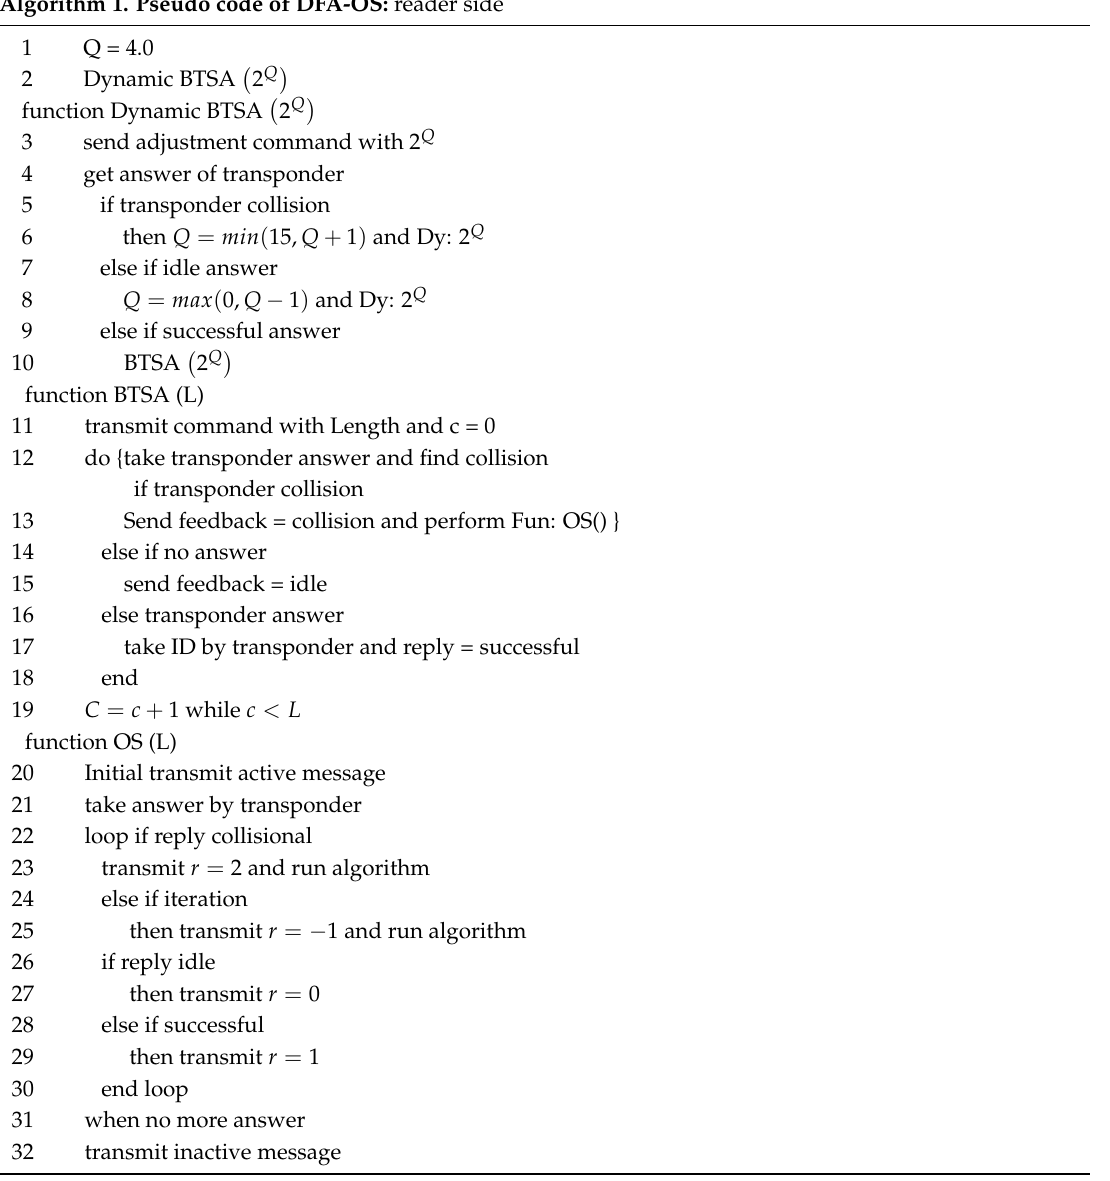
Algorithm 1. Pseudo code of DFA-OS: reader